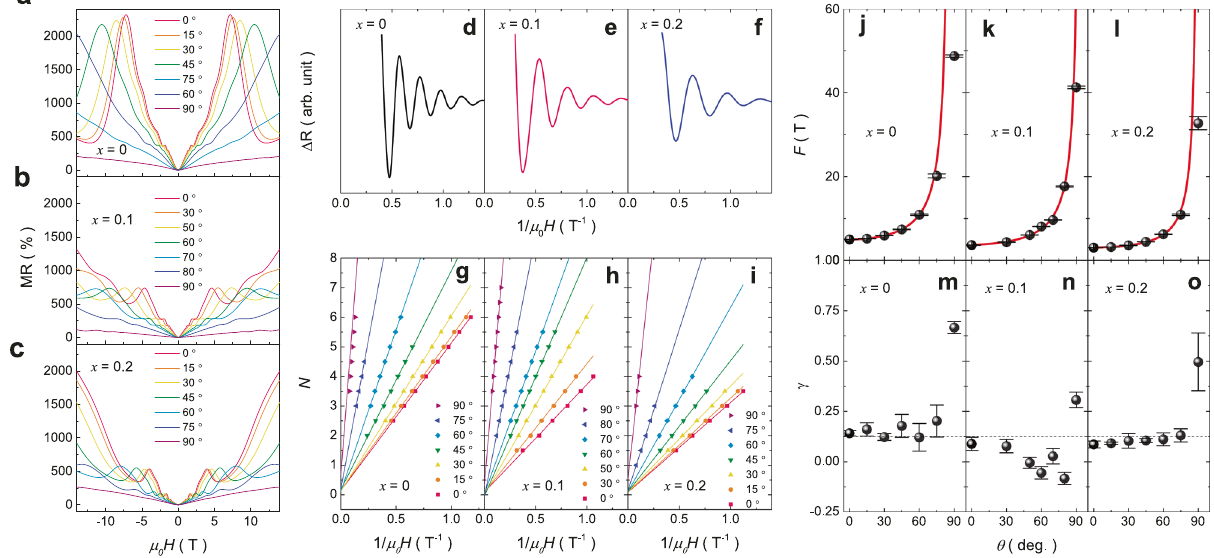
Fig. 3 Angle-dependent magnetoresistance, Shubnikov – de Haas oscillation frequency, and intercept. The magnetic fi eld is swept from the b axis ( θ = 0°) to the a axis ( θ = 90°) while current fl ows along the a axis. a – c Angle-dependent magnetoresistance ratio as a function of a magnetic fi eld. d – f Oscillating components of the magnetoresistance as a function of the inverse magnetic fi eld. g – i Landau fan diagram constructed with oscillation components of d – f . The inverse magnetic fi eld of the oscillation peaks and valleys are assigned to integer and half-integer, respectively. j – l Angle- dependent oscillation frequency, while the red line is 1/cos θ . m – o Landau fan diagram intercepts as a function of angle. The dashed line indicates γ = 1/8. The error bars in j – o are the standard errors of the Landau fan diagram fi